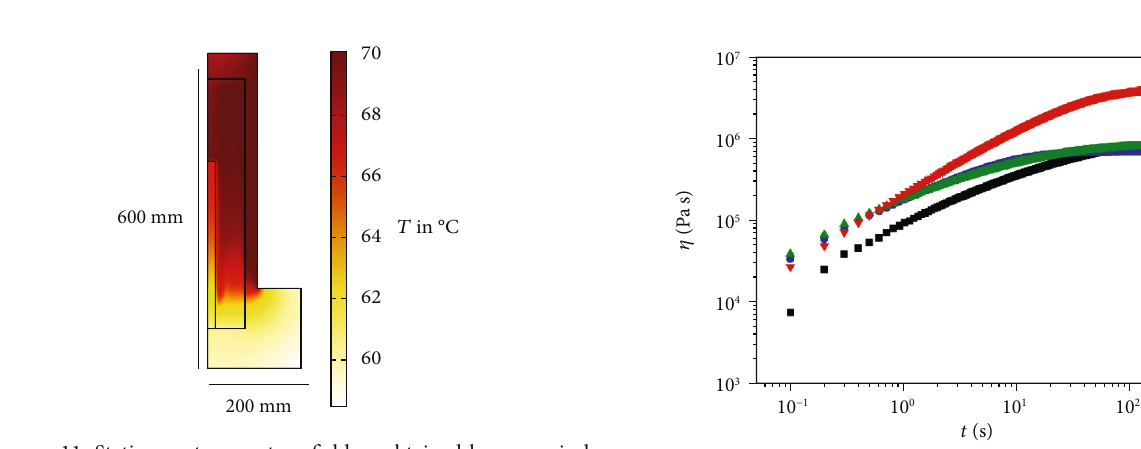
Figure 11: Stationary temperature fi eld as obtained by numerical simulations of the heat equation at a heating temperature of 70 ° C.